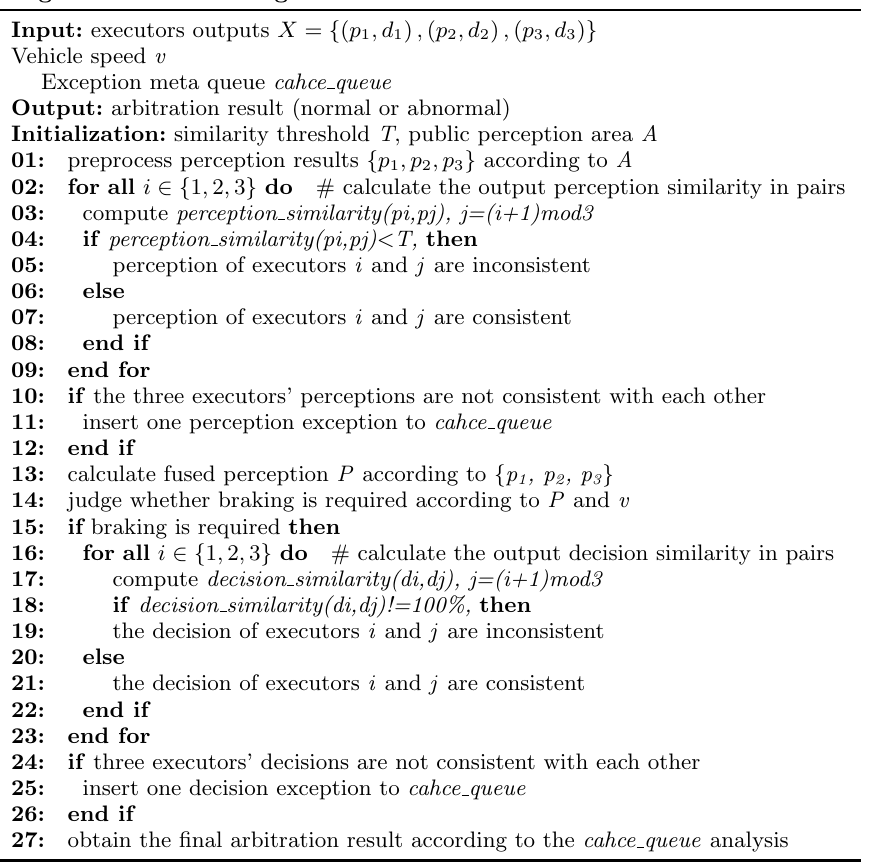
Algorithm 1: overall algorithm of a consensus mechanism